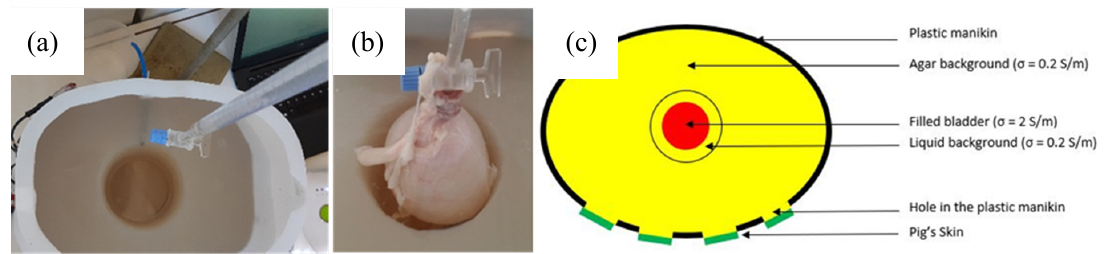
Figure 3. ( a ) Agar background with the hole for the bladder, which includes an emptying pipe; ( b